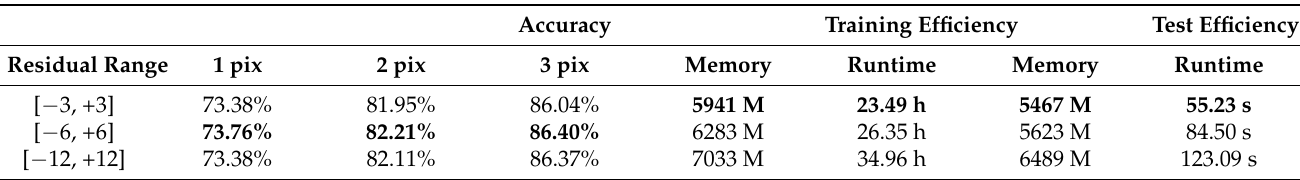
Table 5. Accuracy and efficiency comparison for GA-Net-PyramidED with different residual search